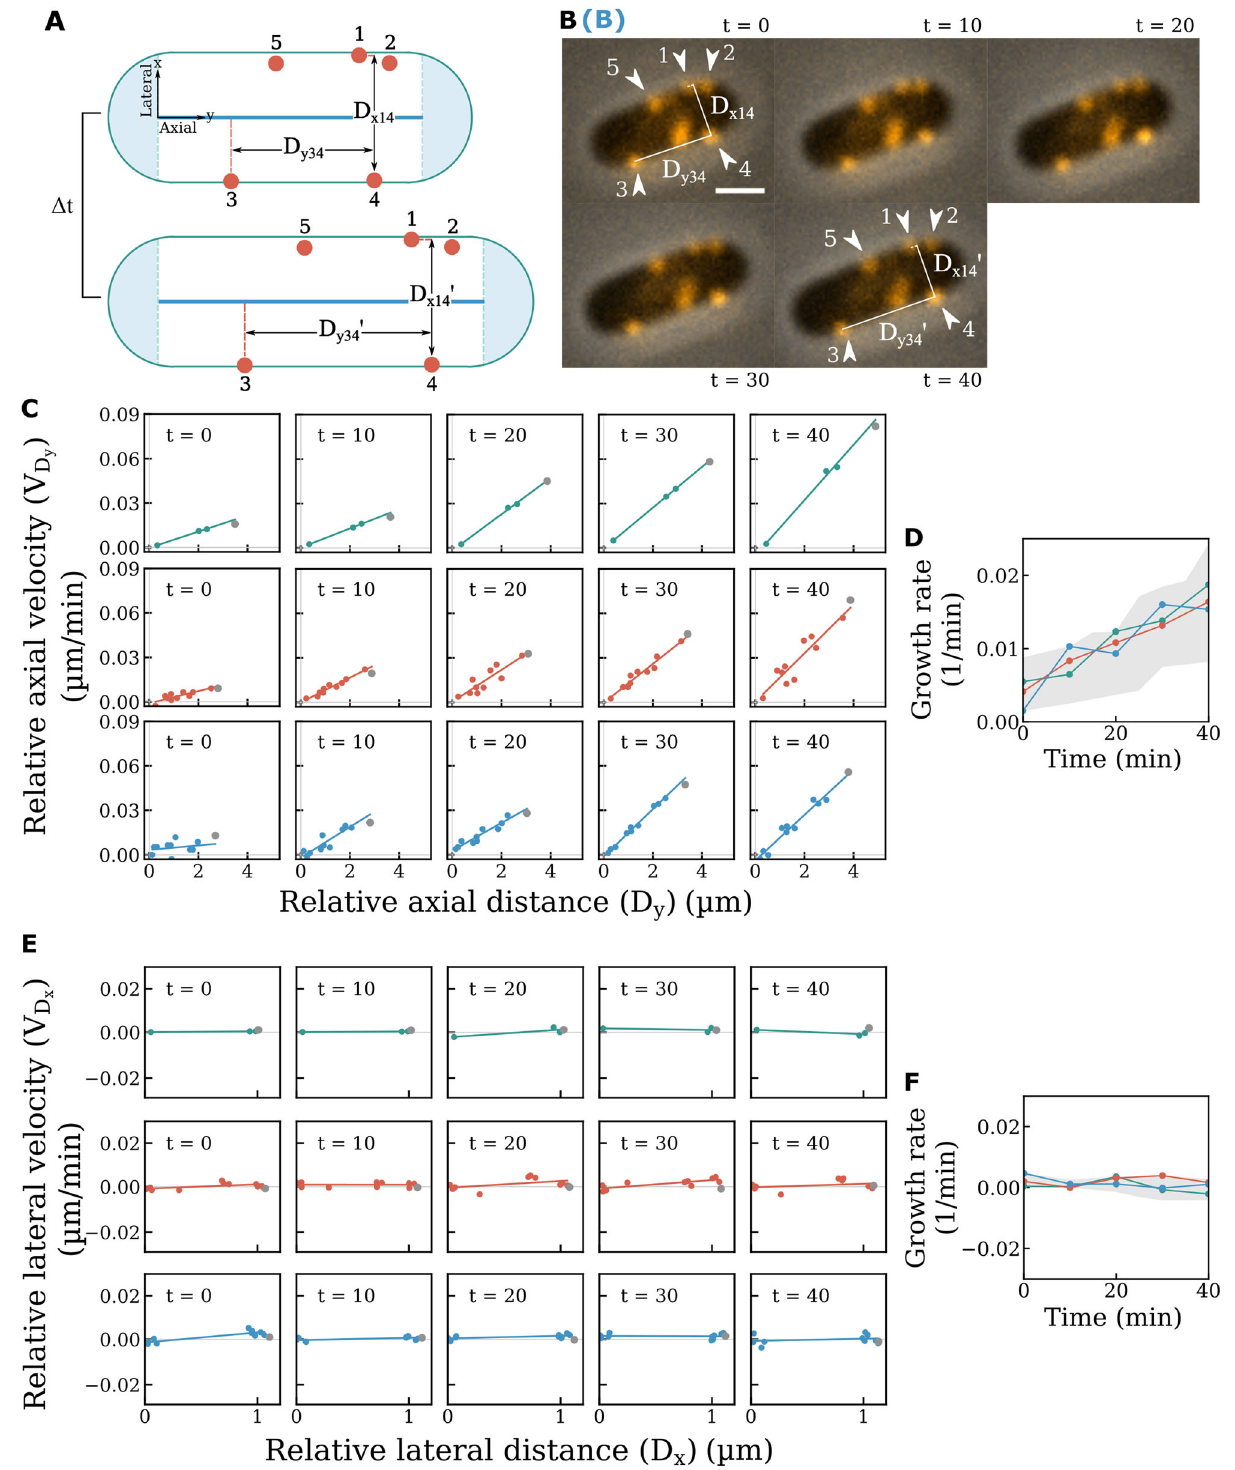
Fig. 2 Expansion dynamics of the cell wall within the active growth zone. A A schematic showing changes in the relative distances between BFM pairs during cell elongation. B Time-lapse fl uorescence images showing changes in the relative distances between BFM pairs in a live cell. Fluorescence and phase-contrast images were overlaid (scale bar, 1 μ m; Δ t = 10min). At least 3 times of the same experiment was repeated with similar results. C The V Dy vs. D y relationship between paired BFMs in three representative cells. Each row shows V Dy vs. D y between paired BFMs from the same cell at different time points. V Dy vs. D y displays a good linear relationship at all times, but the slopes are different, Δ t = 10min. Gray dots represented total cell rod growth velocity vs. cell rod length, which also supported uniform growth of the cell rod. D The axial growth rate increases with time, n = 11 (number of cells). The colors represent data from different cells as in ( C ). The gray area represents the range of the data. E The V Dx vs. D x relationship between paired BFMs in three representative cells [same cells as in ( C )]. Each row shows V Dx vs. D x between paired BFMs from the same cell at different time points. V Dx is ~0 regardless of D x . Gray dots represented total cell width growth velocity vs. cell width. F The lateral growth rate was also zero over time, n = 7 (number of cells). The gray area represents the range of the